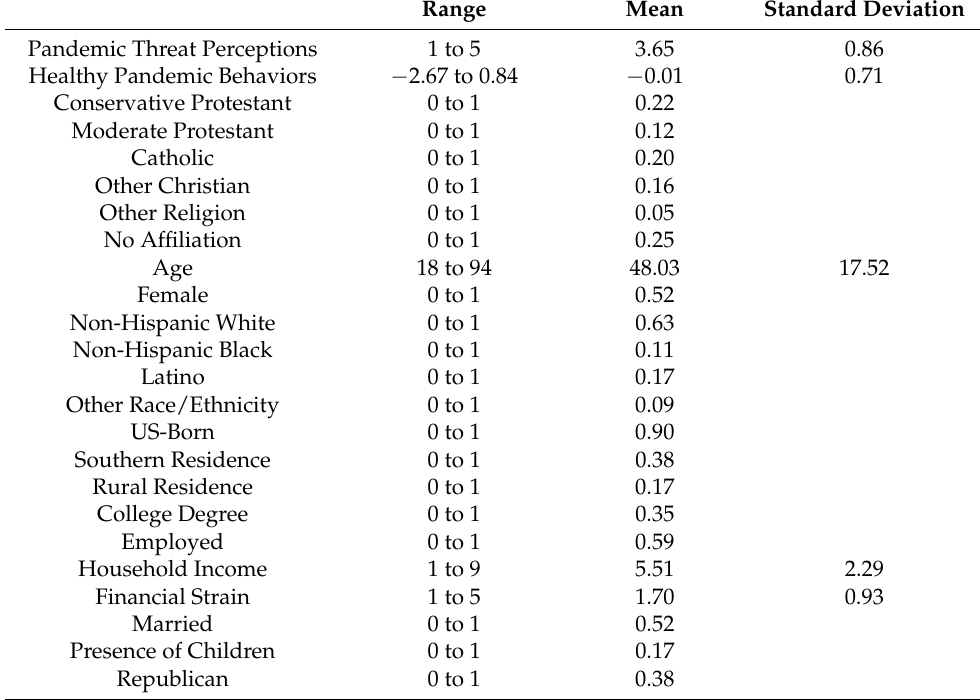
Table 1. Weighted descriptive statistics (CHAPS